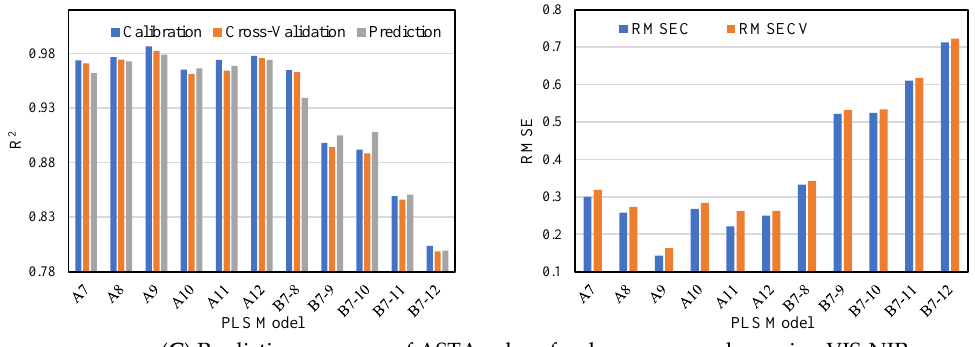
( C ) Prediction accuracy of ASTA color of red pepper powders using VIS-NIR